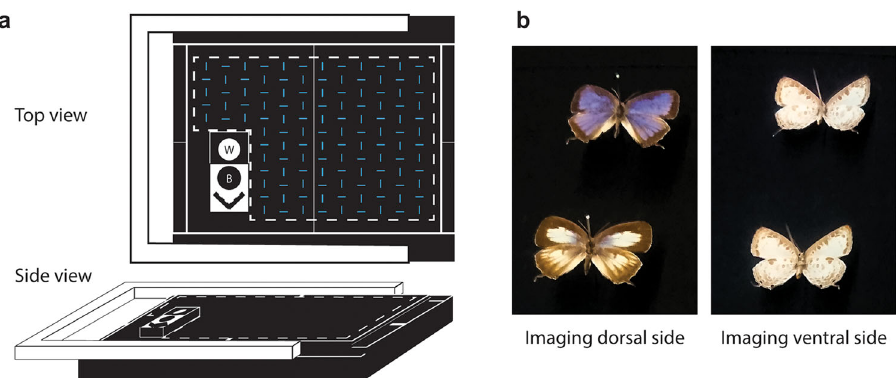
Fig. 2 The design of the imaging platform accommodating both dorsal and ventral sides of specimens. a The hidden pre-cut slots are illustrated in blue. White dashed lines, indicating the region that shows up in the image, were labeled by black sewn lines on the imaging platform for user guidance. The scale bar and black/white standard references are in the lower left corner. Details of the multi-layer foam backing can be found in Fig. 6. b The examples showing how dorsal and ventral sides of specimens being placed on the imaging